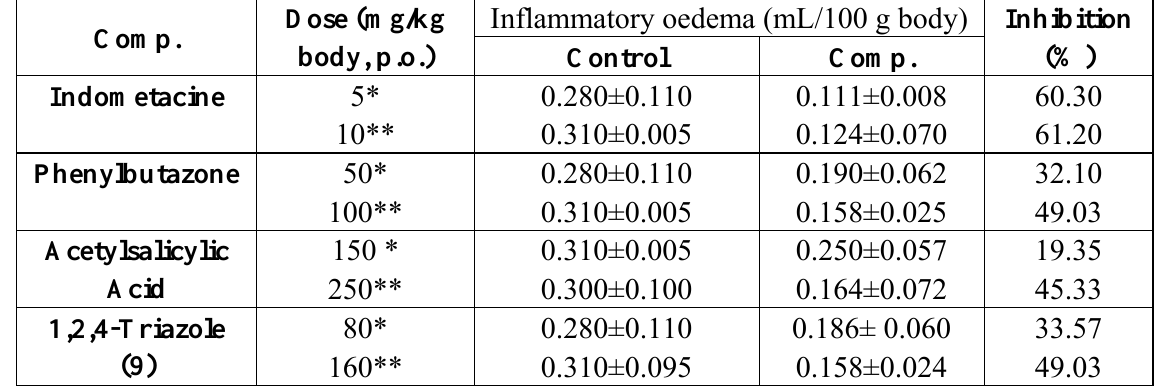
Table 2. The anti-inflammatory effects of tested